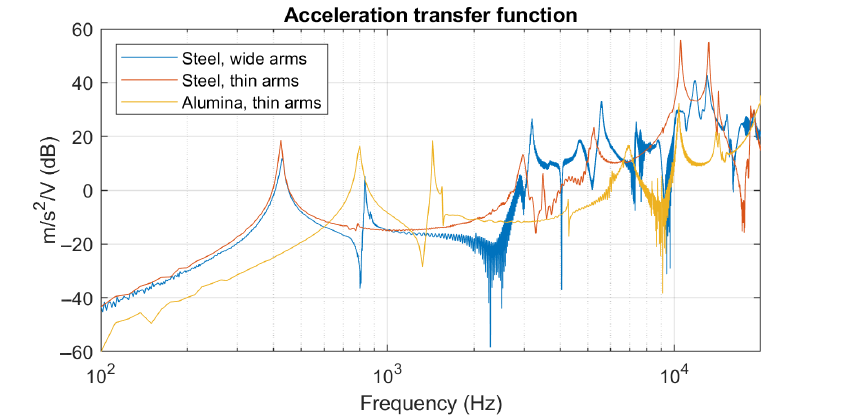
Figure 19. Acceleration transfer functions measured at the centre of different